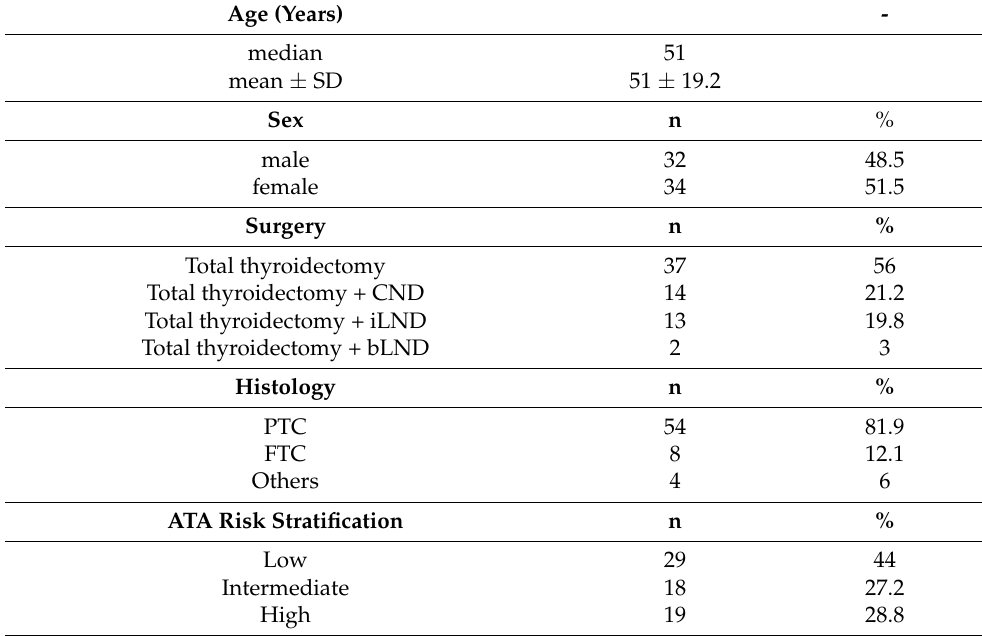
Figure 1. Diagnostic flow-chart of patient selection. Table 1. Summary of patients’ clinical demographic features.